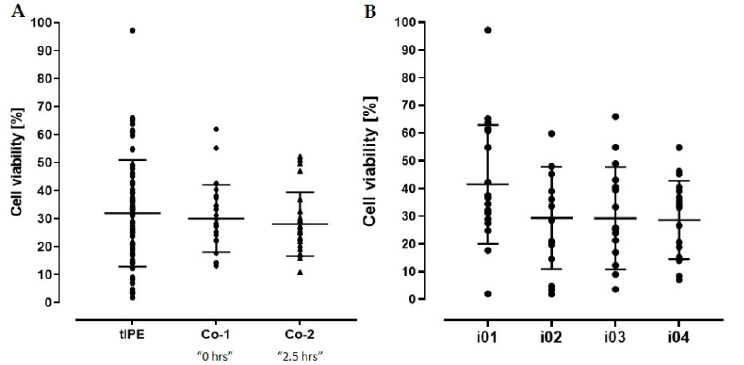
Figure 7. Cell viability of tIPE and non ‐ transfected control cells. ( A ) There was no difference in the percentage of viable cells between tIPE and controls (tIPE: 31.92 ± 19.04%; Co ‐ 1: 30.062 ± 12.04%; Co ‐ 2: 28.02 ± 11.40%) ( p > 0.999). ( B ) Individual analysis of the iridectomies i01–i04 showed that cell viability did not decrease during the time elapsed while processing one eye (i01: 41.46 ± 21.45%; i02: